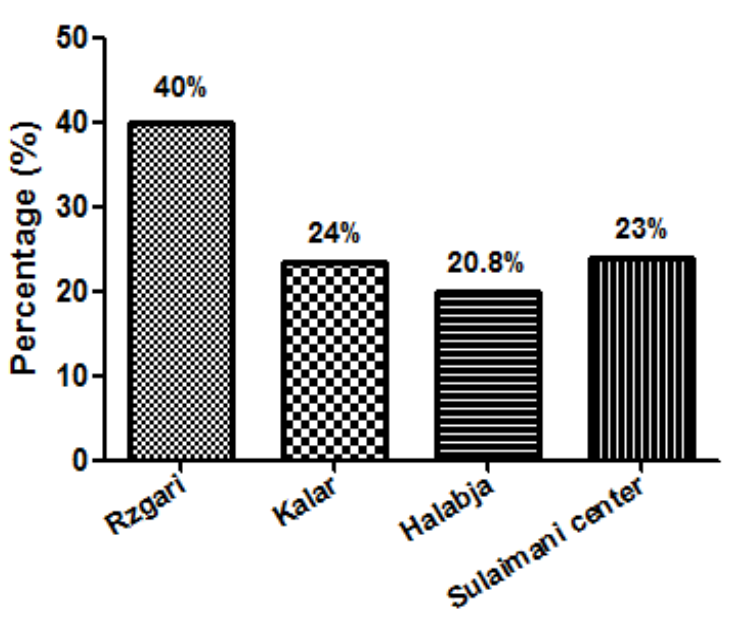
Figure 2. The prevalence rate of Echinococcus granulosus egg among stray dogs in different areas of Sulaimani Governorate, Sulaimani Governorate, Kurdistan—Iraq.